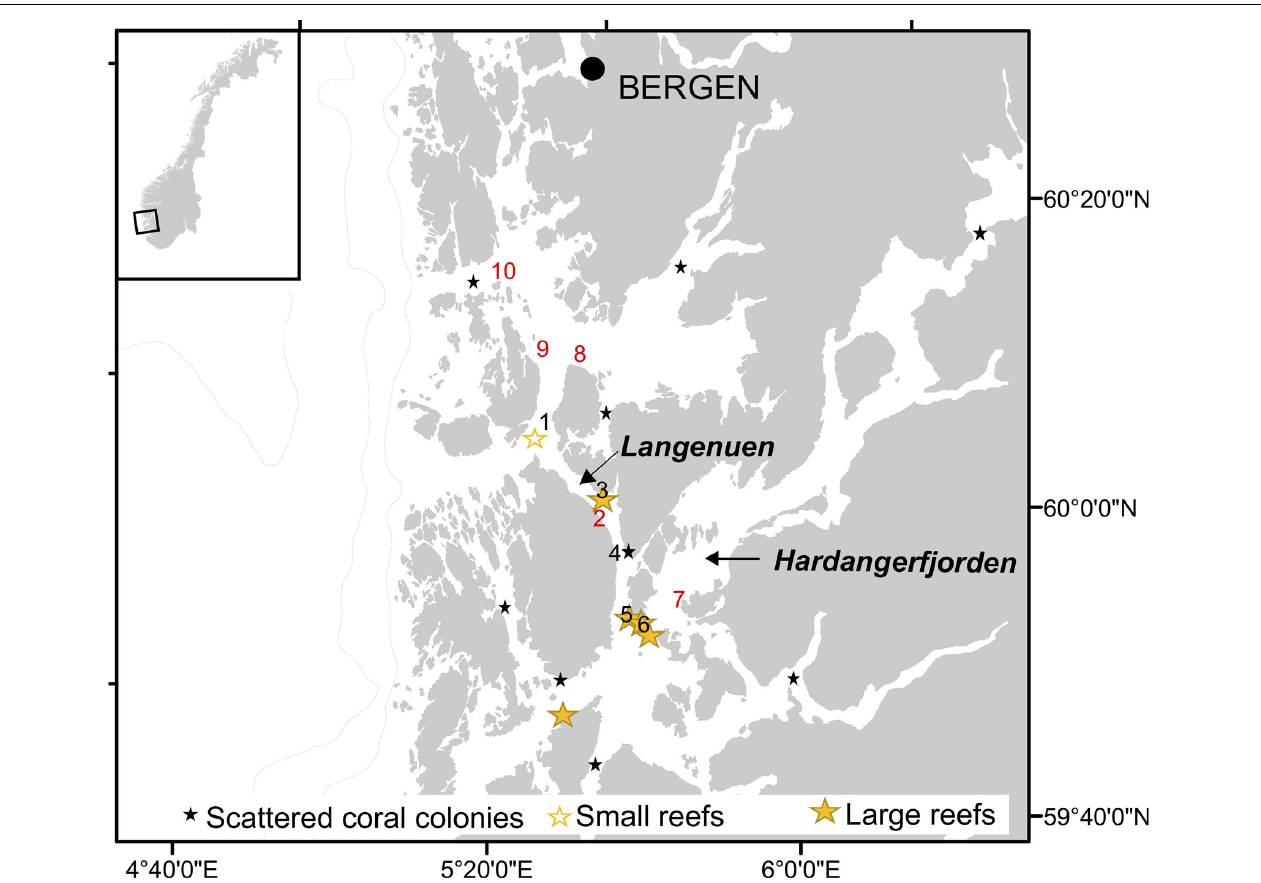
FIGURE 1 | Map showing Hardangerfjorden and Langenuen straight (western Norway) and the locations where water samples were collected for quantification of Lophelia pertusa eDNA (nr. 1–10). Black numbers denote locations known to harbor cold-water corals (CWCs) and red number denote locations known not to have CWCs. Also shown (by stars) is the distribution of known CWC ecosystems in the region, classified into scattered coral colonies, small reefs and large